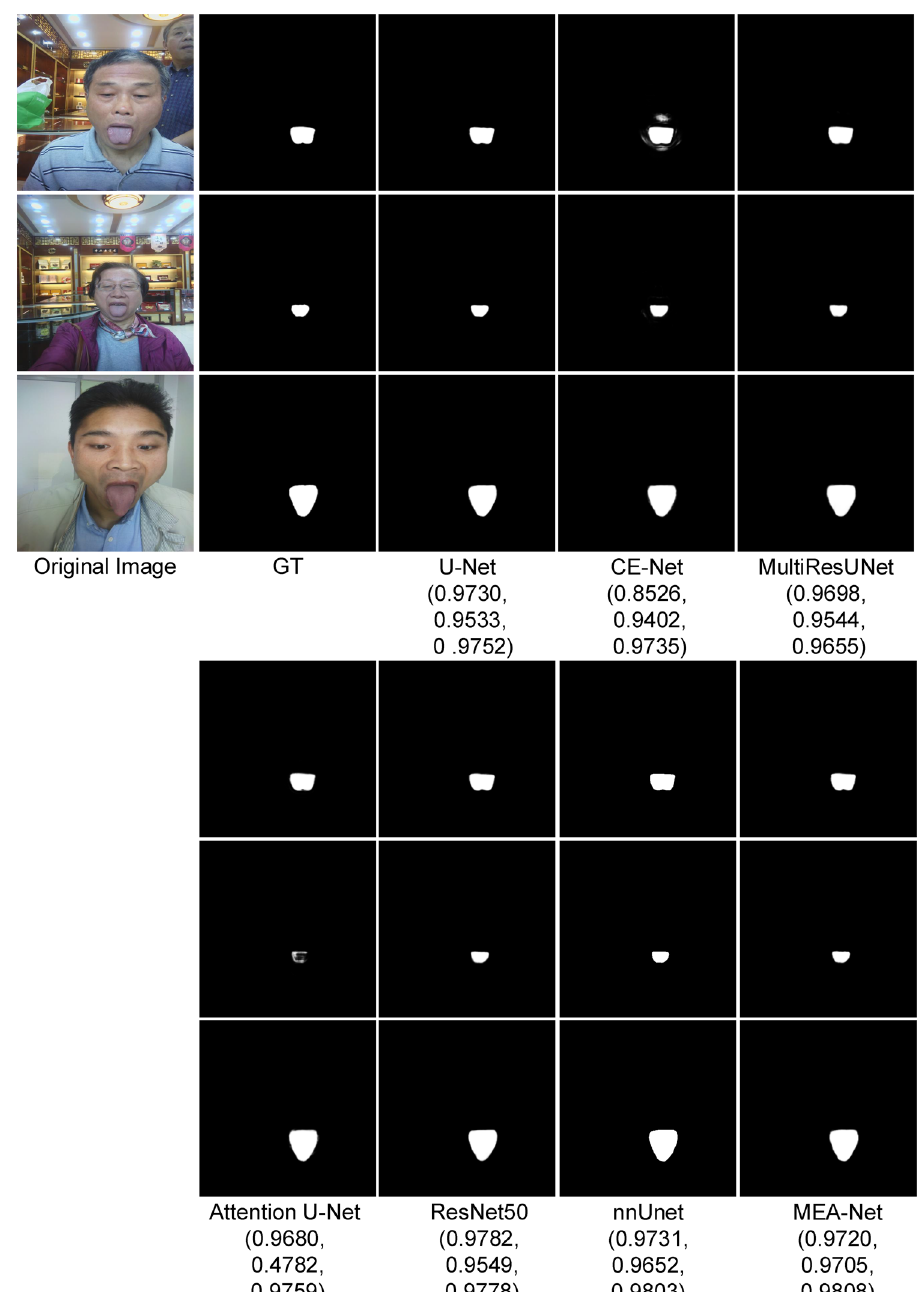
Figure 9. Sample results of clinical image segmentation. (The Dice values for each legend are in